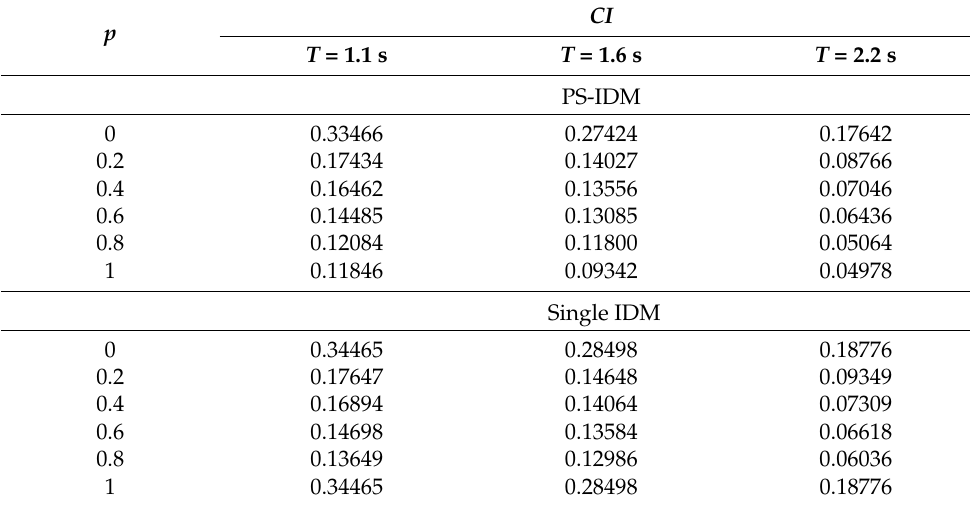
Table 4. PS-IDM and Single IDM comfort